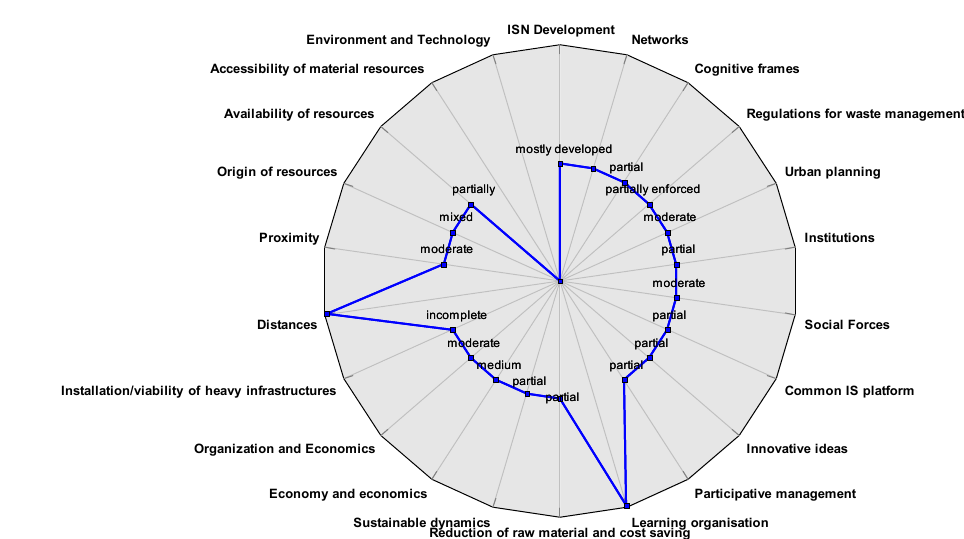
Figure 8. Polar chart of the selected attributes for ISN in Rotterdam.